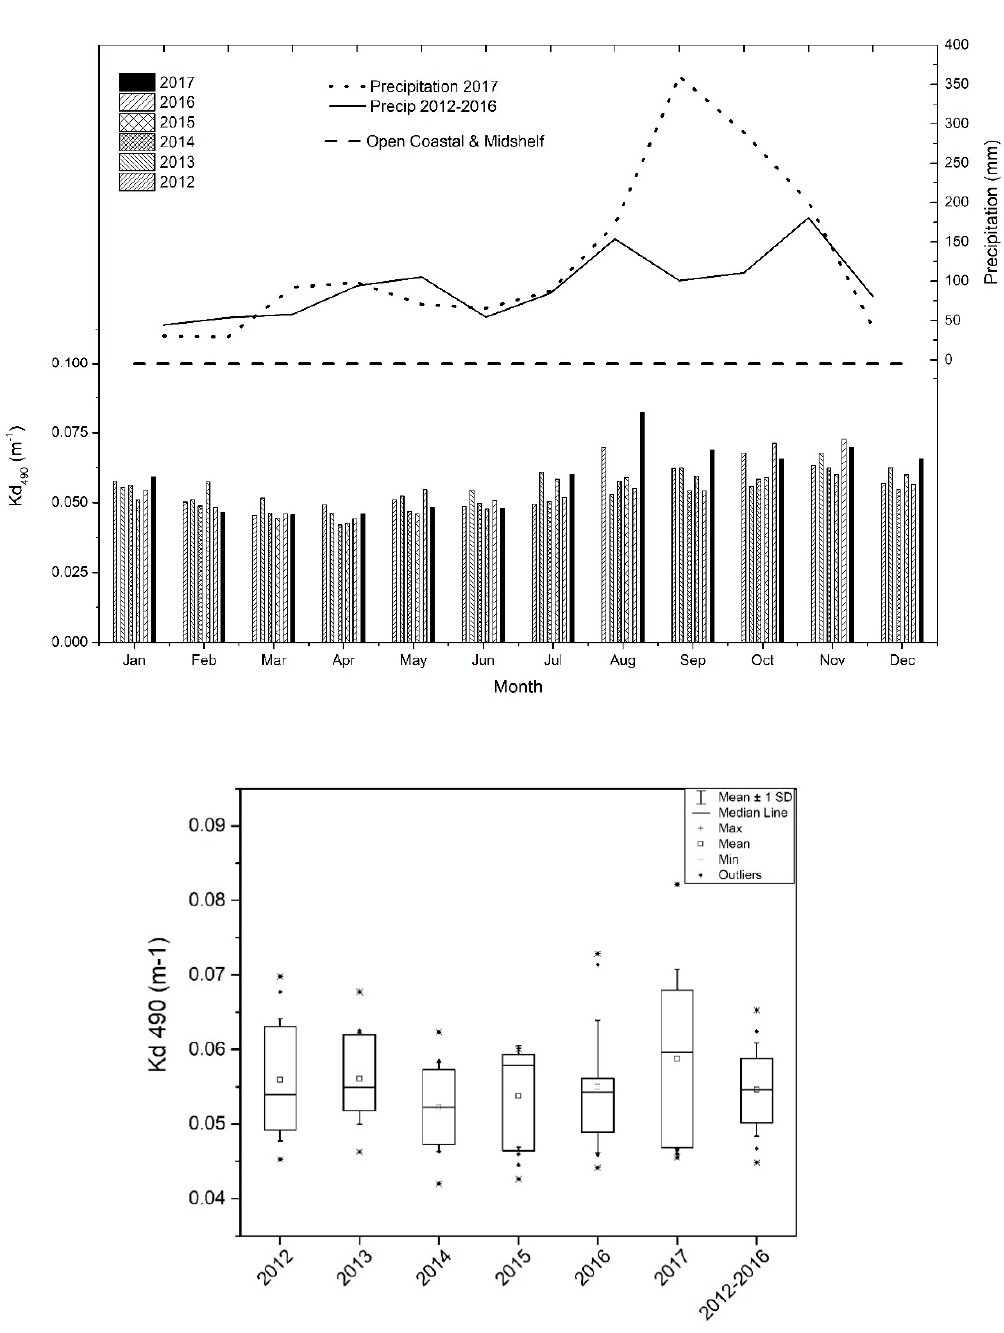
Figure 8. Monthly comparison of K d 490 values showing the yearly distribution from 2012–2017 with associated precipitation data (top). The year 2017 is filled in black. The dashed line for 0.1 m − 1 represents the K d 490 value threshold for open coastal waters [22]. (Bottom) Box plot showing yearly statistics of K d 490 for all regions.